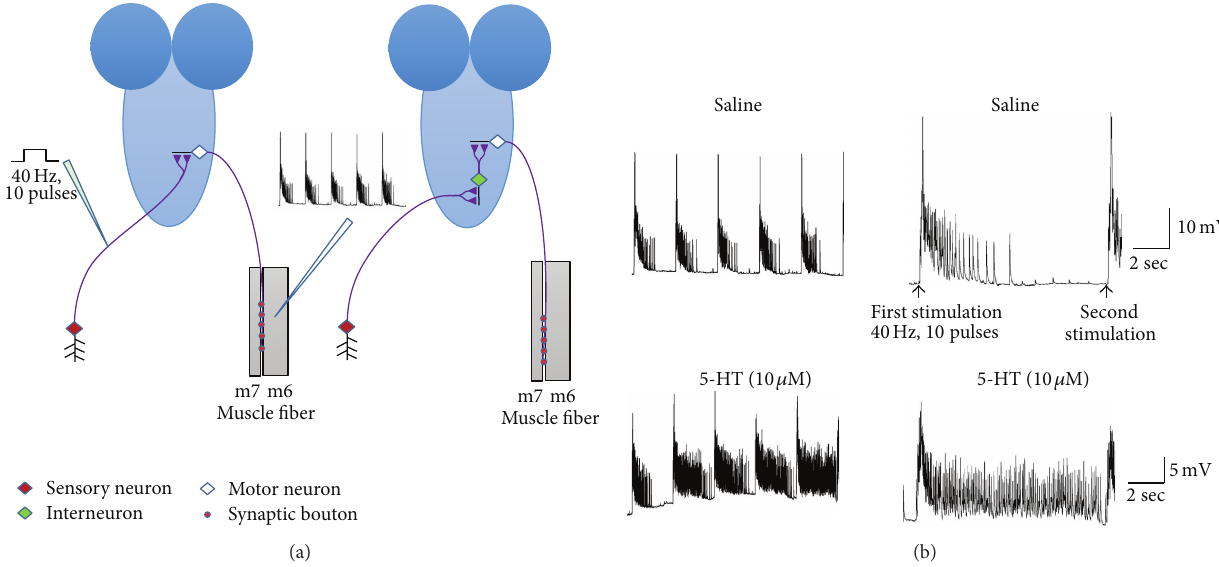
Figure 11: The effect of 5-HT on a CNS circuit. (a) shows two hypothetical models for the sensory-motor circuit. The first model is a monosynaptic model (left side) with sensory neurons directly making synaptic connections with motor neurons. The second model is a multisynaptic one in which the sensory neurons make synaptic connections with interneurons and then the interneurons make connections with the motor neurons. The two segmental nerves that innervate the last segment were cut and pulled into a suction electrode. The segmental nerves were stimulated at 40Hz, 10 pulses, and the excitatory postsynaptic potentials (EPSPs) were being recorded from body wall muscle fiber 6 or 7. (b) The modulatory action of 5-HT on sensory-motor function in third-instar larvae. Application of 5-HT noticeably increased the frequency of evoked EPSPs. The far right traces are enlarged depictions of one evoked burst shown to the left.